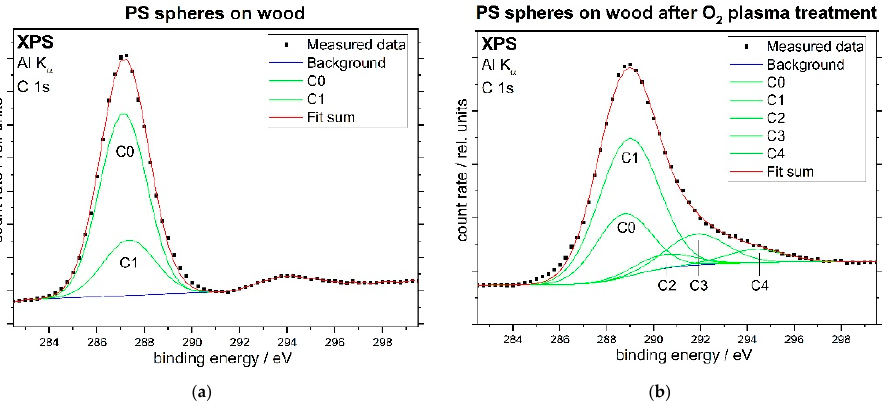
Figure 5. XPS C 1s spectra of the PS sphere coated pine wood sample before ( a ) and after O 2 plasma treatment ( b ). Table 1. XPS binding energies according to [41].